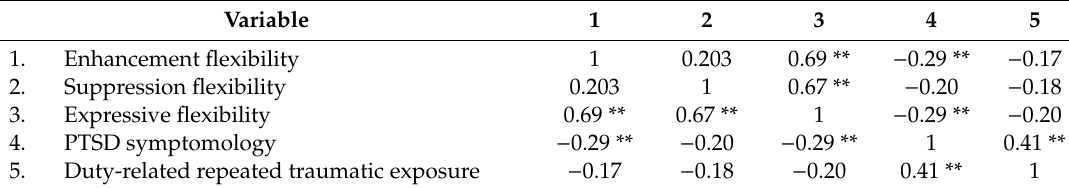
Table 1. Zero-order correlation between enhancement flexibility, suppression flexibility, expressive flexibility, PTSD symptomology and duty-related repeated traumatic exposure.